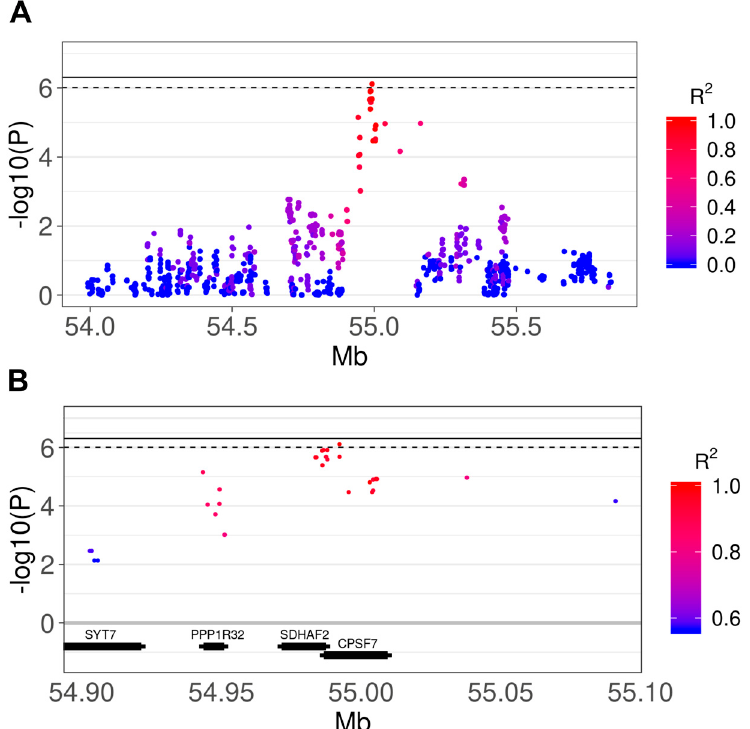
Figure 2. Manhattan plots showing the details of the association region in chromosome 18. The continuous and dashed lines indicate the genome-wide and suggestive significance thresholds, respectively. The color of the points indicates the LD (expressed as R 2 ) between the top (rs22669389) and the close SNPs. Values of R 2 range from 0 (absence of LD) to 1 (complete LD). Figure 2B shows a smaller R 2 range due to the closeness of the top SNP. ( A ) Region ± 1 Mb from the top SNP; ( B ) region ± 0.1 Mb from the top SNP. Thick sections of the genes represent the actual gene region according to Ensemble, the thin sections represent the surrounding regions ( ± 1500).